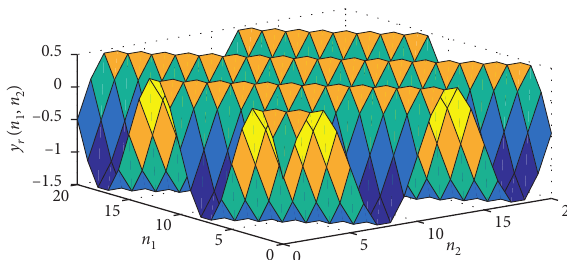
and MATE ( 2 ) with iteration number k by using the ILC law (9). k k